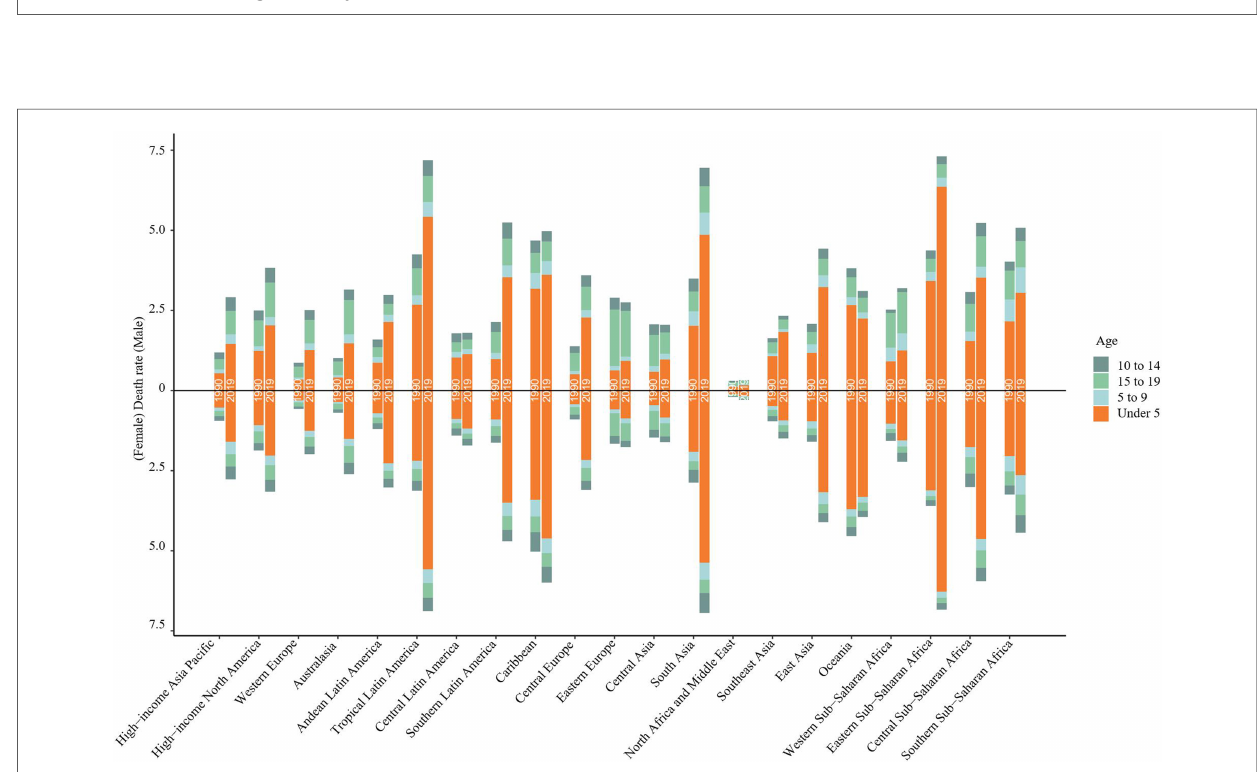
FIGURE 9 Changes in death rate due to childhood myocarditis and cardiomyopathy between 1990 and 2019 by age group in 21 global regions. The death rate of myocarditis and cardiomyopathy in children under fi ve years of age increased signi fi cantly in 2019 compared to 1990 in all regions except